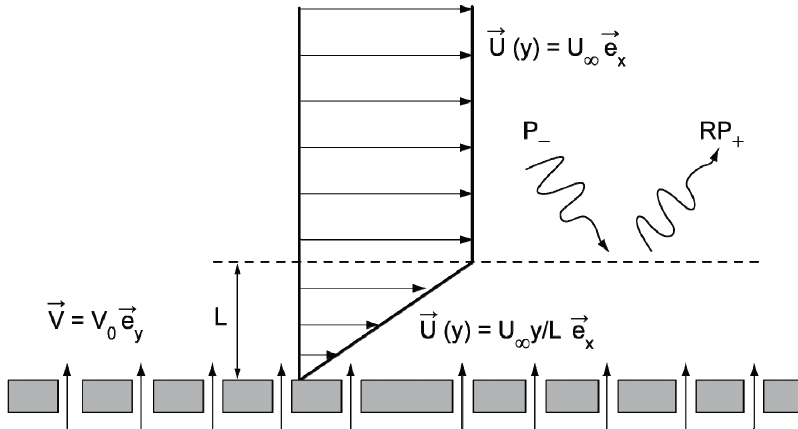
Figure 11. Acoustic liner with bias flow in a sheared boundary layer. The methods of noise reduction include: (i) reduction of noise at the source (Figure 16); (ii)